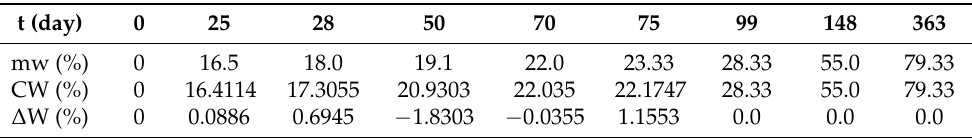
Table 5. Results obtained using the weight loss profile data from [43]. The grey shaded values are the result of visual